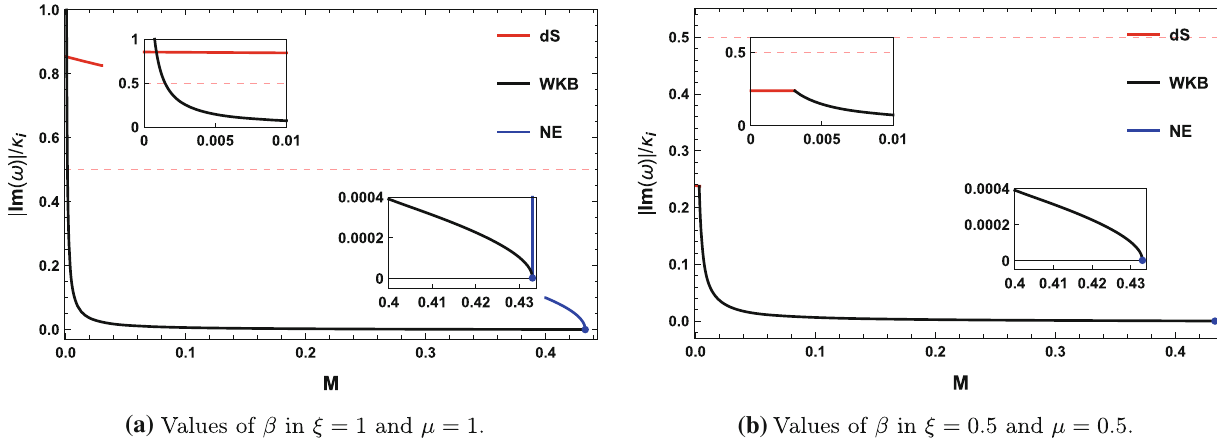
Fig. 4 Values of β of quasinormal modes with two limits of MTZ black holes